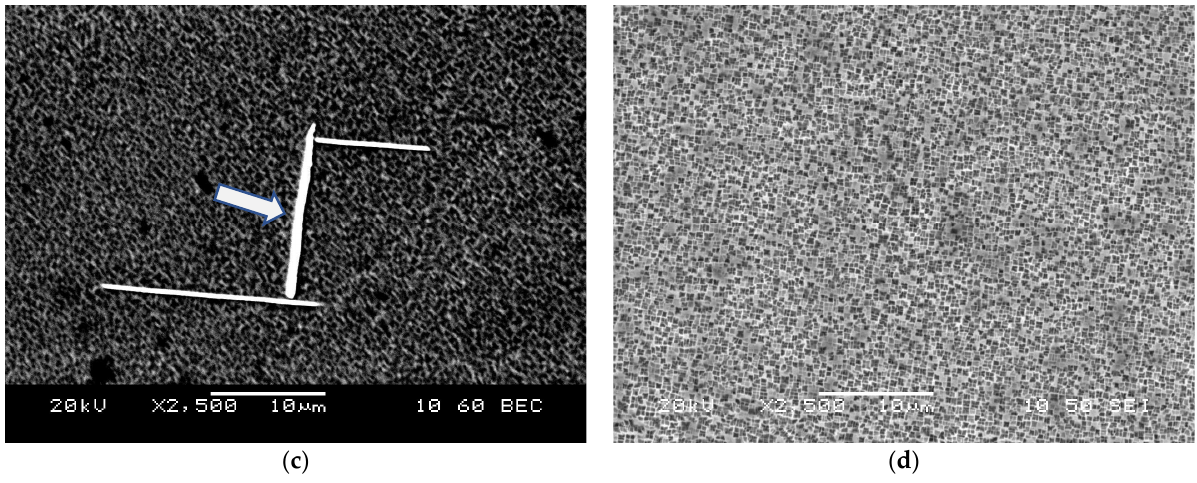
Figure 1. The microstructure of the dendritic cores of samples of different solution times: as-cast ( a ), 1 h ( b ), 8 h ( c ), and 24 h ( d ). The TCPs are clearly seen in ( c ) as white linear phases indicated by an arrow.